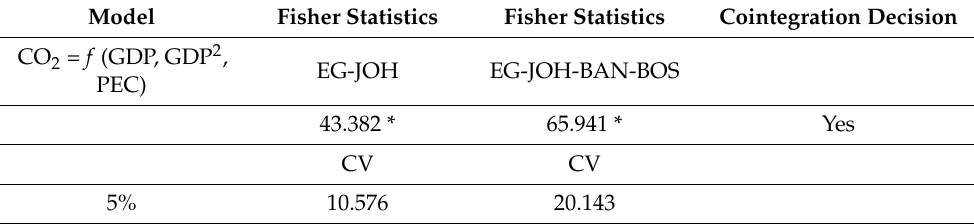
Table 7. Bayer–Hanck cointegration